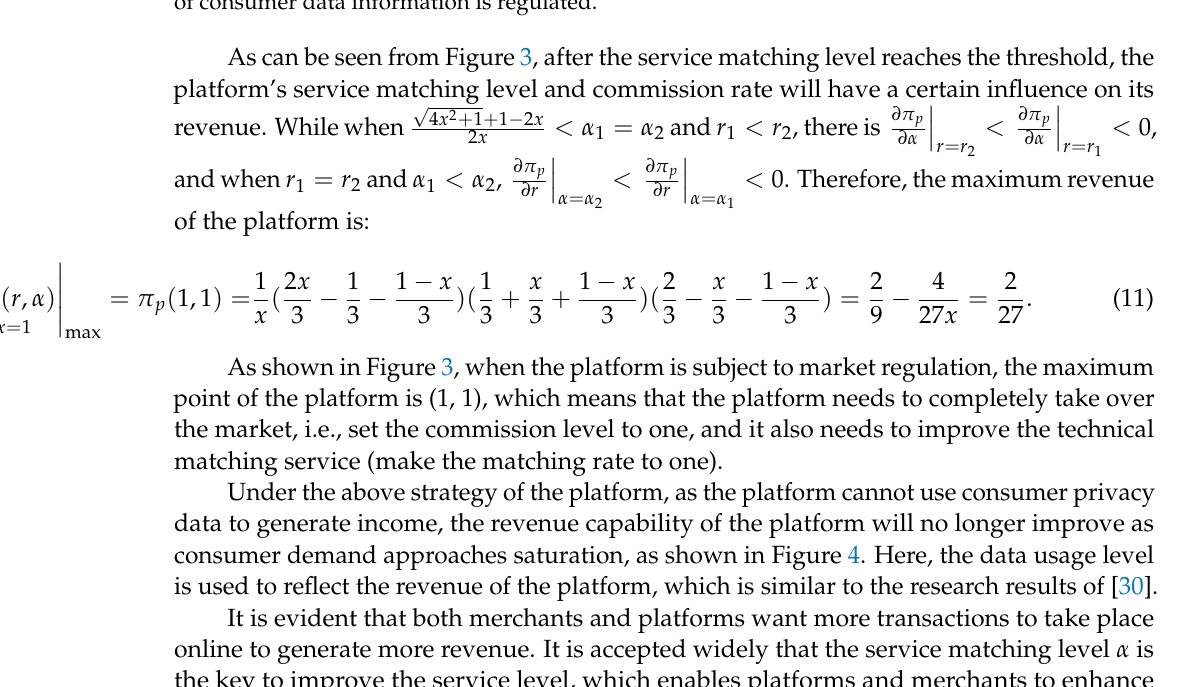
Figure 3. The platform revenue changes with the matching level and commission rate when the use of consumer data information is